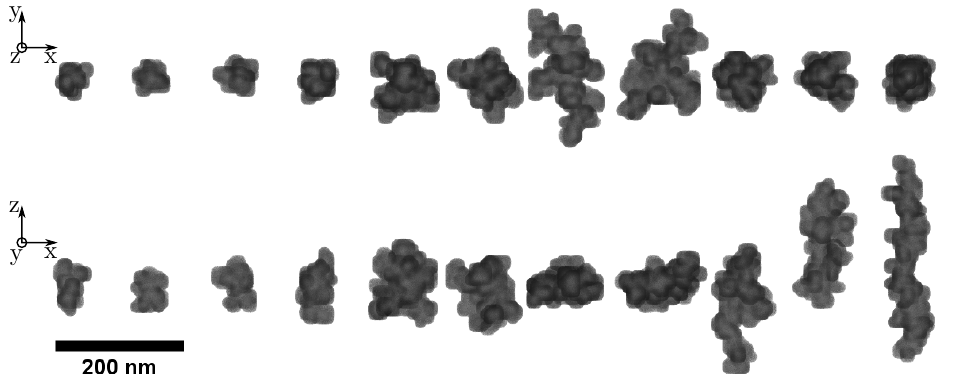
Figure 5. Two dimensional (2D) image of eleven unique nanoparticles (NPs) of the virtual particle system (VPS) created by the custom diffusion-limited-aggregation (DLA) algorithm (M1). Two different projections are shown to visualize differences is nanocluster